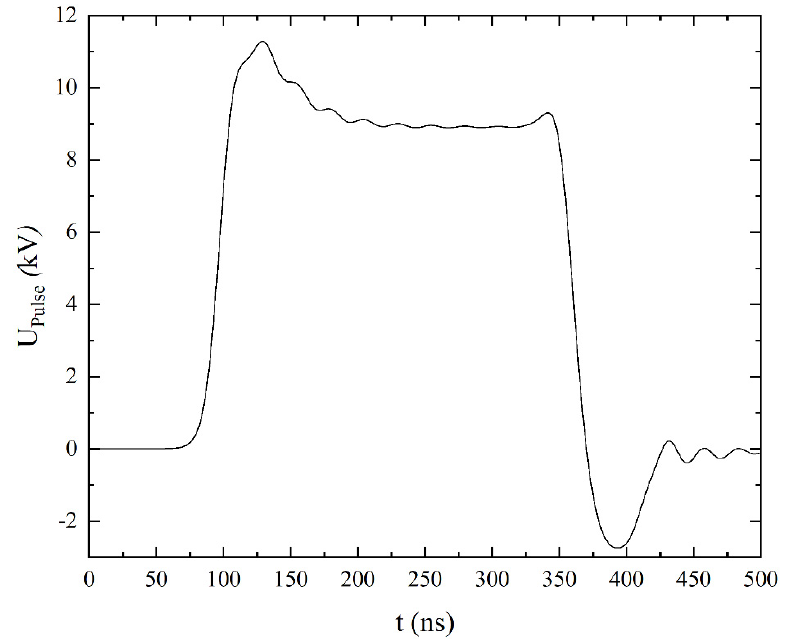
Figure 5. Impulse voltage waveform across the needle-plane electrode system, obtained by the model shown in Figure 4. The charging voltage applied to the Blumlein generator was 10 kV.